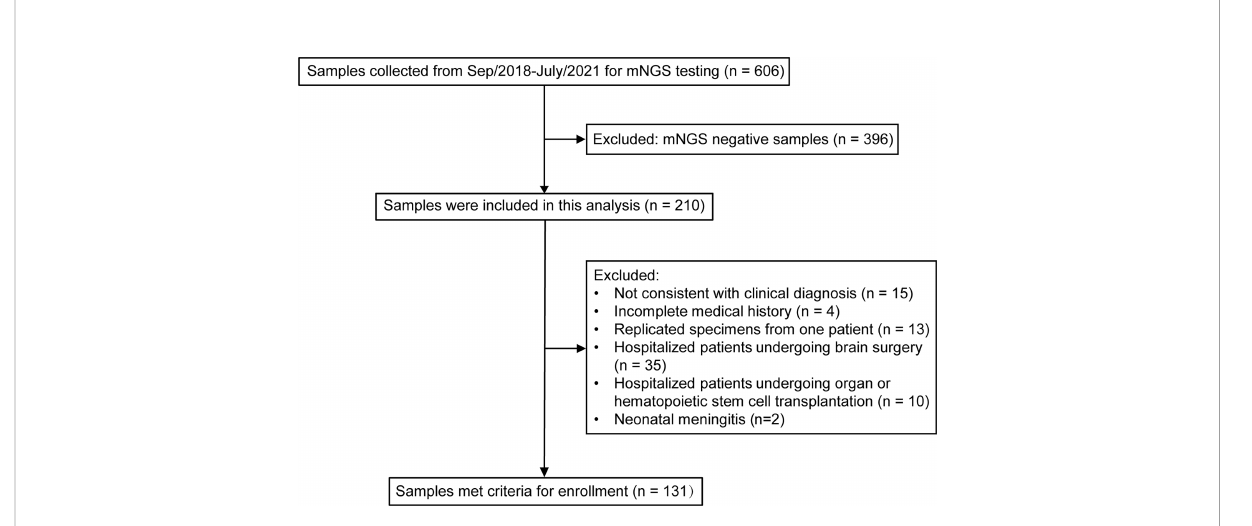
FIGURE 1 Flowchart of study